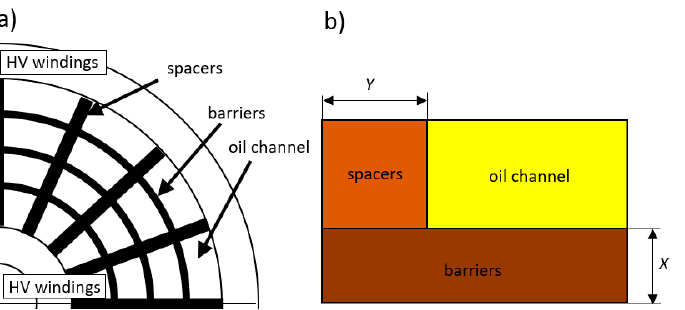
Figure 9. A portion of the transformer insulation cross-section, with a cylindrical arrangement of windings ( a ) and a simplified transformer insulation model ( b ).